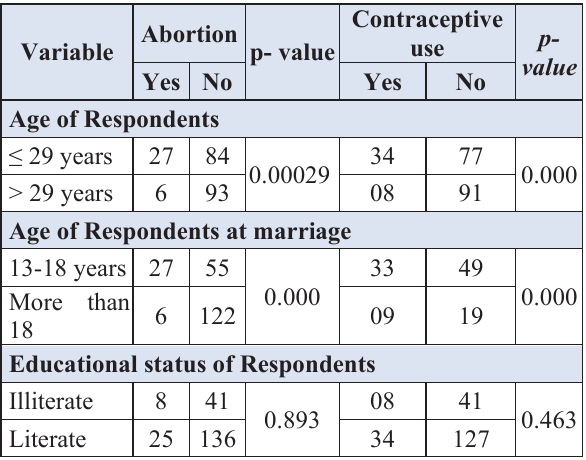
Table-4: Socio-demographic determinants of abortion and contraceptive use